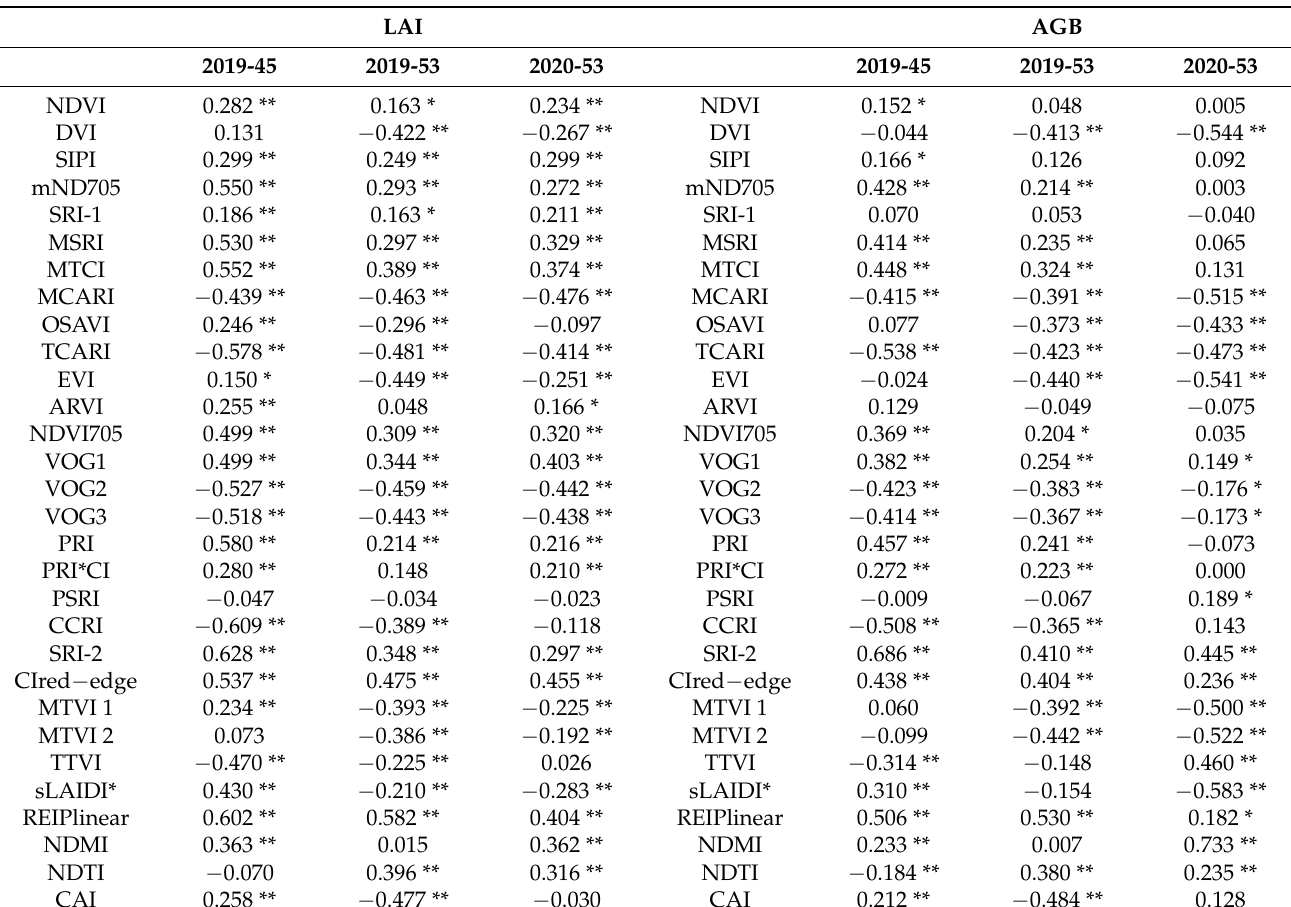
Table 7. Correlations between spectral indexes among different years and varieties and LAI and AGB of cotton. LAI